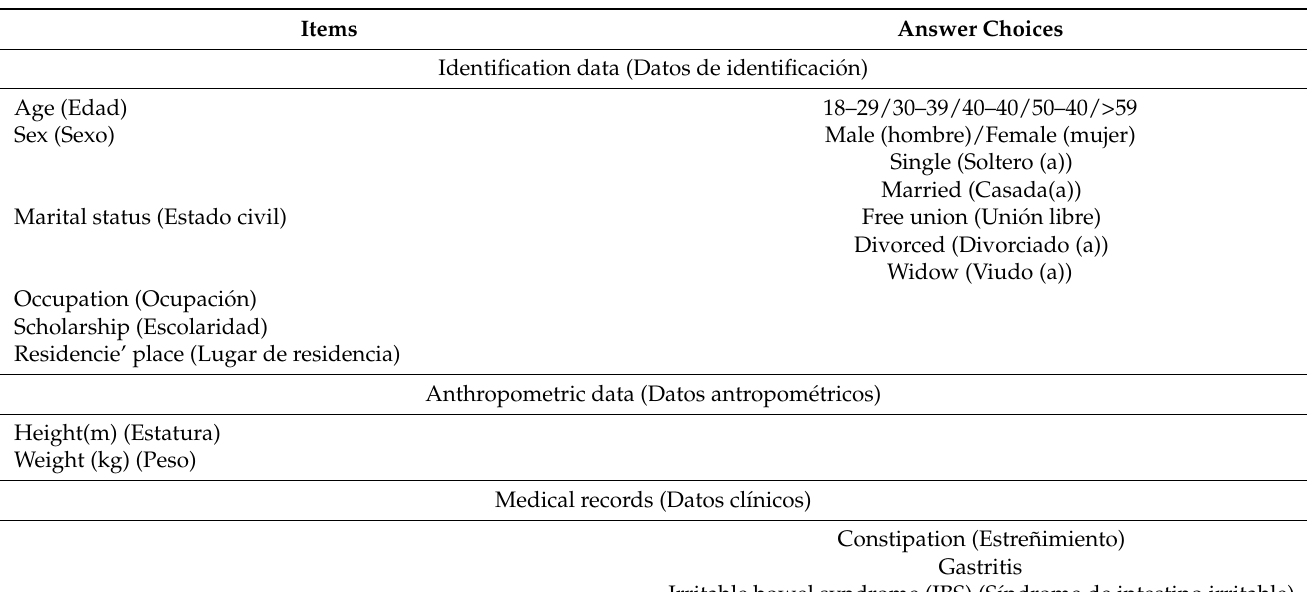
Table A1. Survey of phenolic compound